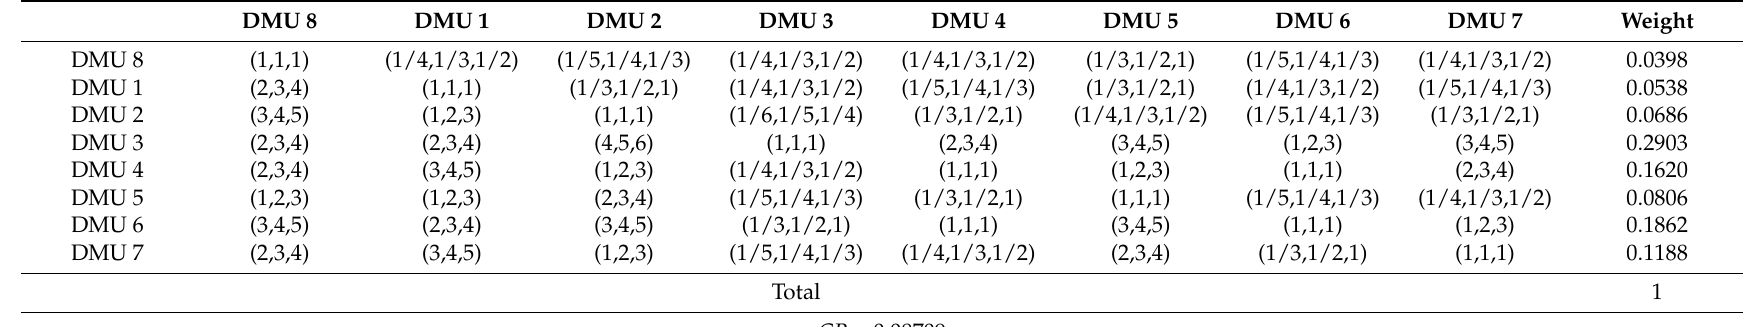
Table A25. Comparison matrix for DLT based on